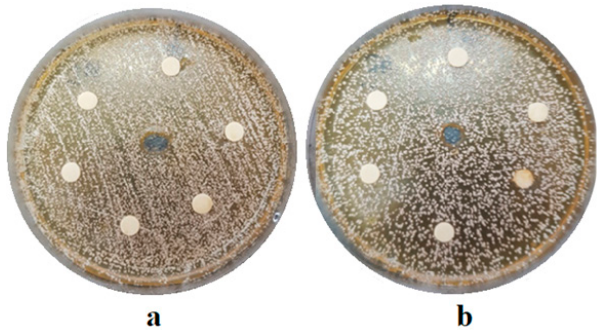
Figure 5. Mean values of inhibition diameters for S. mutans strain as a function of concentrations and quantities.